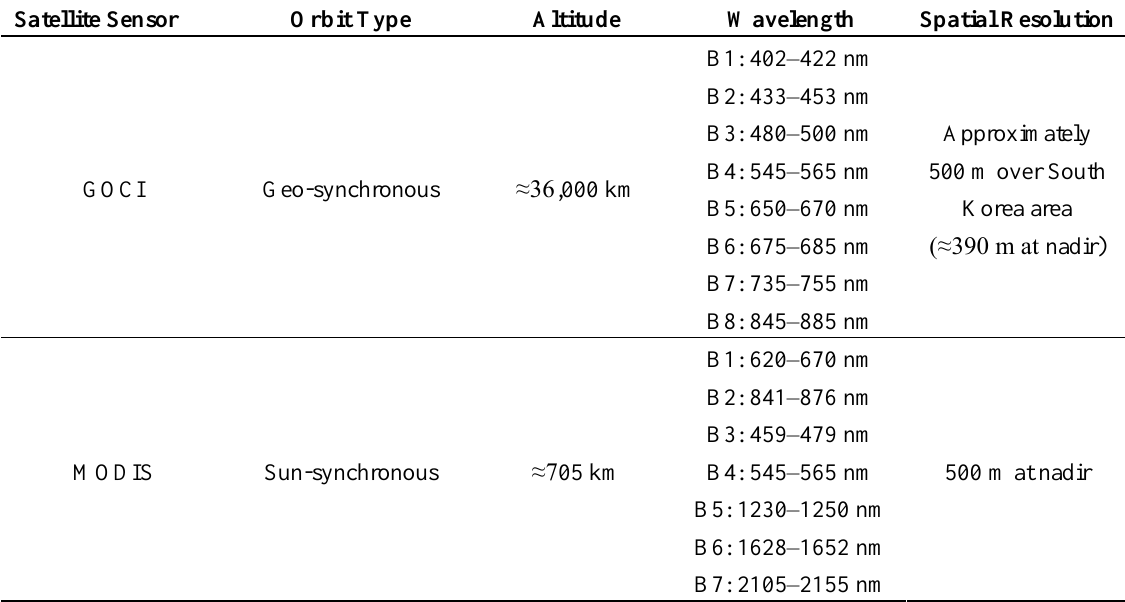
Table 1. Detailed characteristics of the GOCI and MODIS sensors used for estimating land-surface